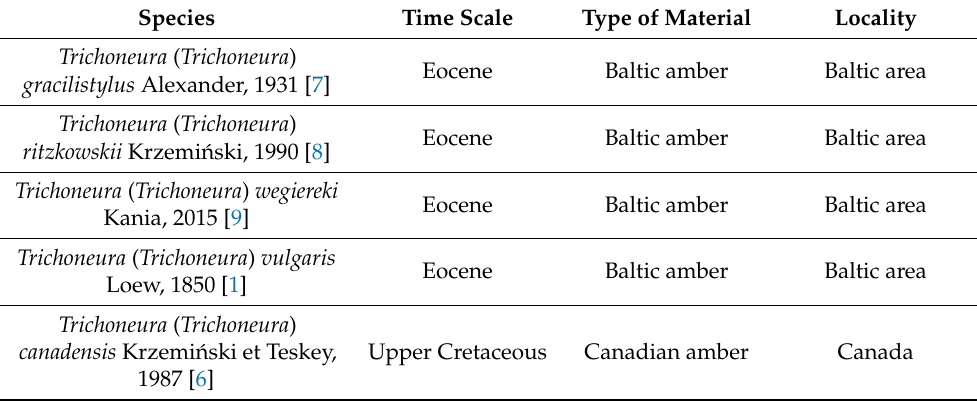
Table 1. List of species of Trichoneura previously known from fossil record.